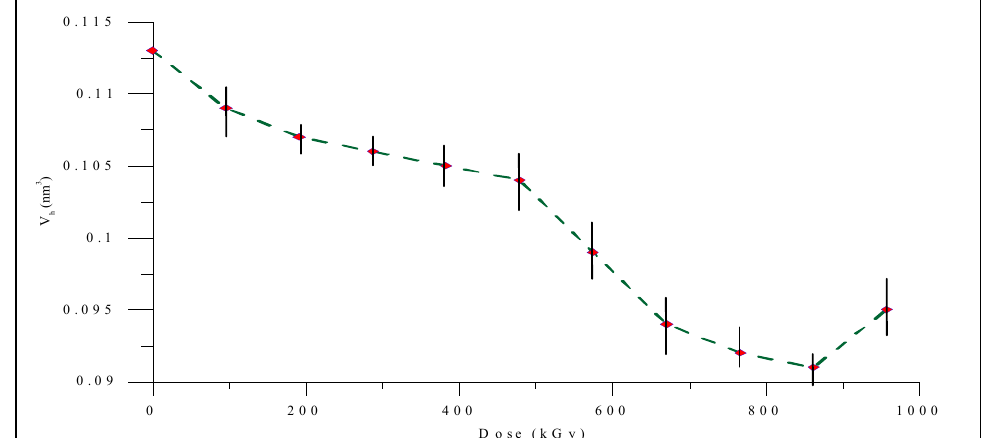
Fig. 4: Vh for EP as a function of γ -dose.